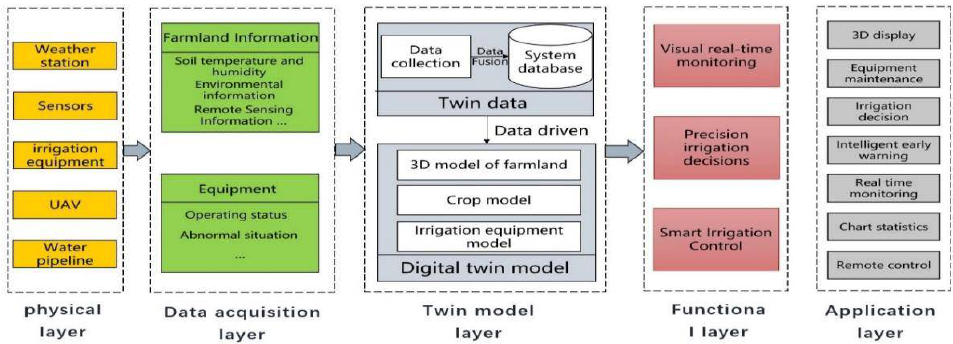
Figure 3. Block diagram for an intelligent irrigation system using a digital twin.